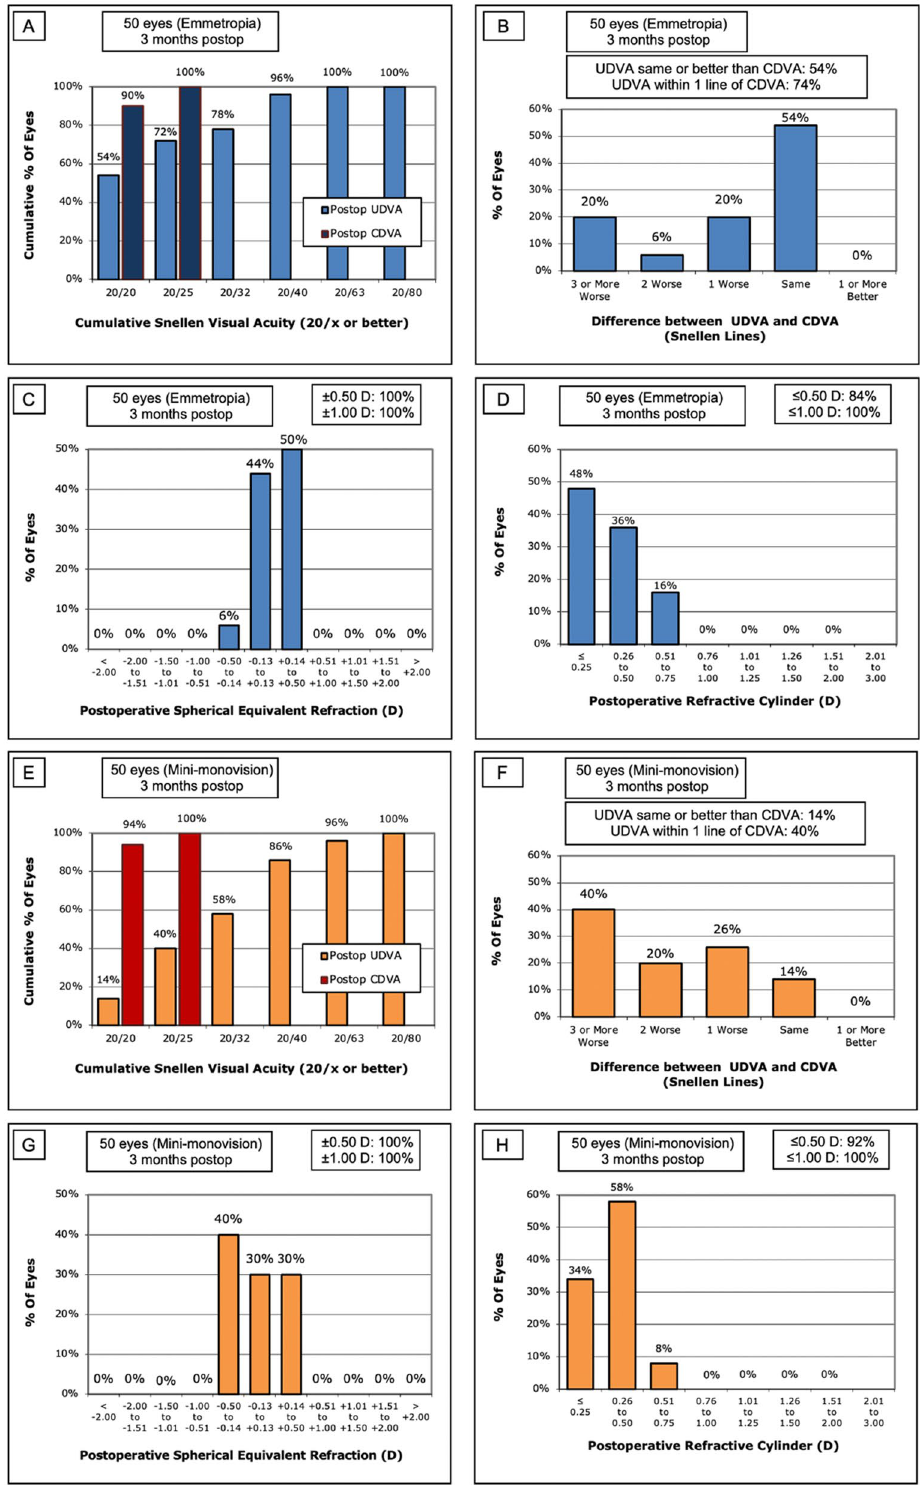
Figure 1. Standard graphs for reporting refractive outcomes for Emmetropia ( A – D ) and Mini-monovision ( E – H ) groups. ( A , E ) Cumulative percentage of postoperative UDVA and CDVA, ( B , F ) Cumulative percentage of lines of difference between postoperative UDVA and CDVA, ( C , G ) Postoperative spherical equivalent refraction relative to the intended target, ( D , H ) Postoperative refractive cylinder. D